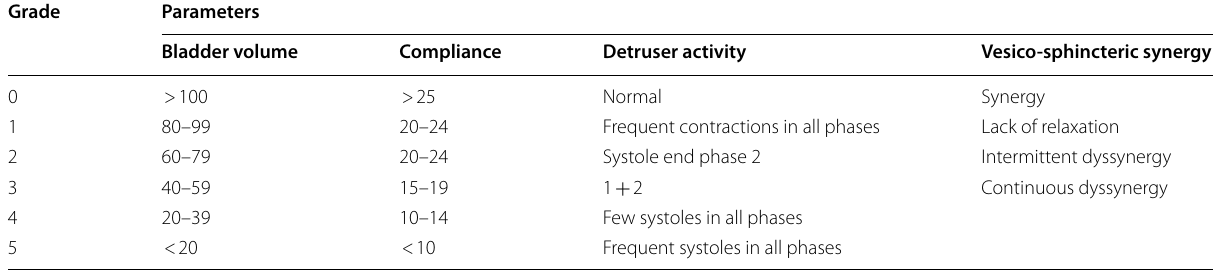
Table 2 Grading of the urodynamic study parameters by Meyrat et al. [17]. The 4 parameters that were included were: 1.